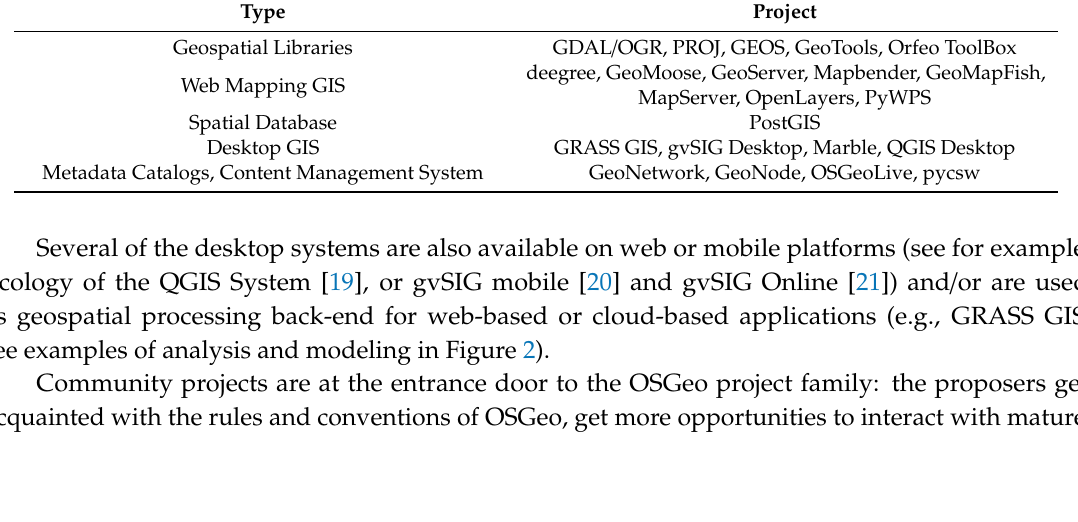
Table 1. Open Source Geospatial Foundation (OSGeo) projects by type of software.